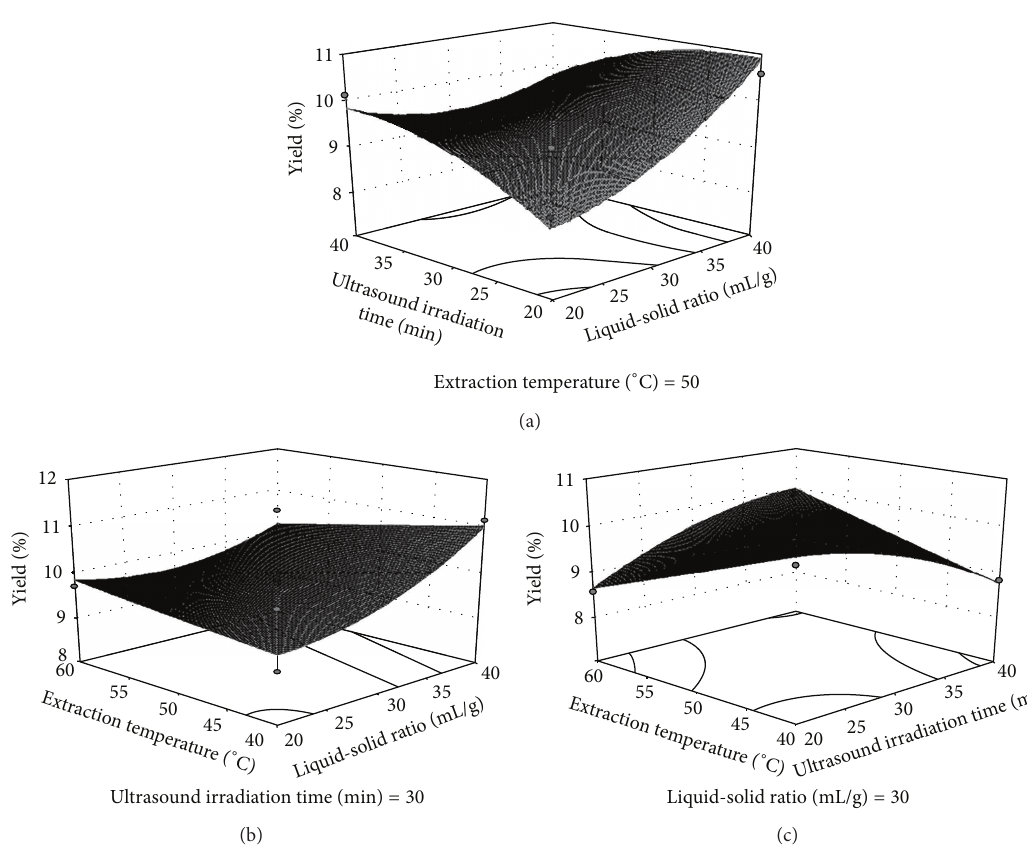
Figure 1: Response surface plots showing the effects of variables on the UAE extraction yield of larch arabinogalactan. (a) Interaction of liquid-solid ratio and irradiation time. (b) Interaction of liquid-solid ratio and extraction temperature. (c) Interaction of irradiation time and extraction temperature.